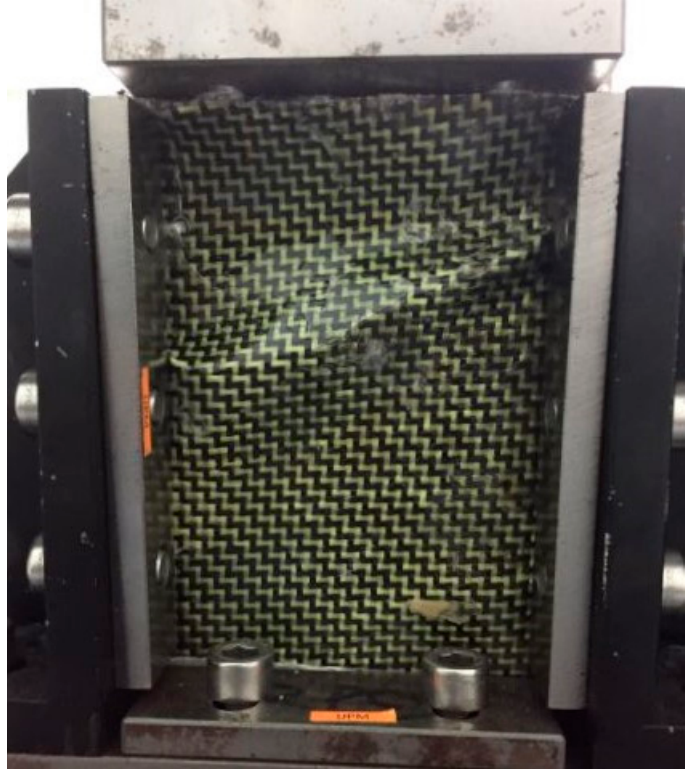
Figure 14. The CAI testing condition of the banana-epoxy sandwich structures subjected to an impact energy of 15 J.